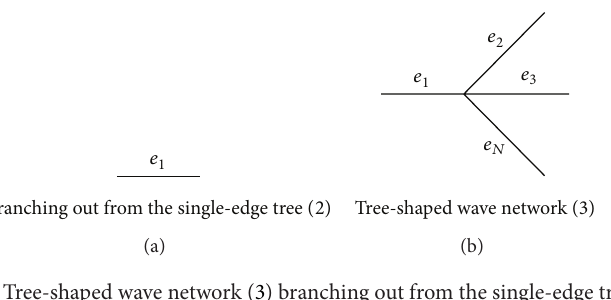
Figure 1: Tree-shaped wave network (3) branching out from the single-edge tree